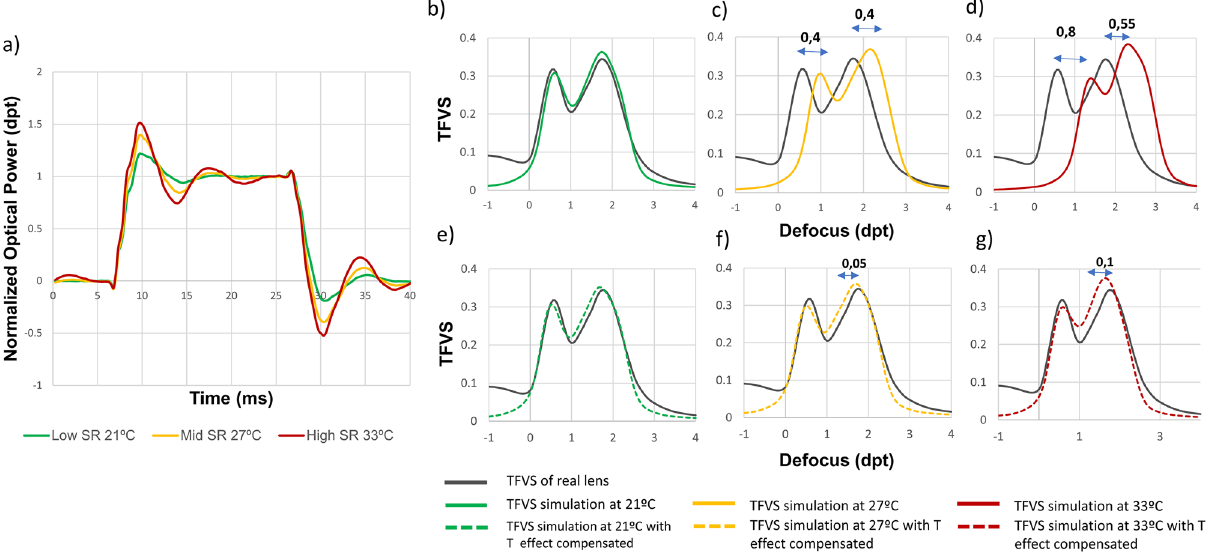
Figure 8. Characterization of TL dynamic behavior at different temperatures. ( a ) Step response measurement of the TL at 3 temperatures 21 °C, 27 °C and 33 °C. TFVS ratio of the simulation of a multifocal lens design at